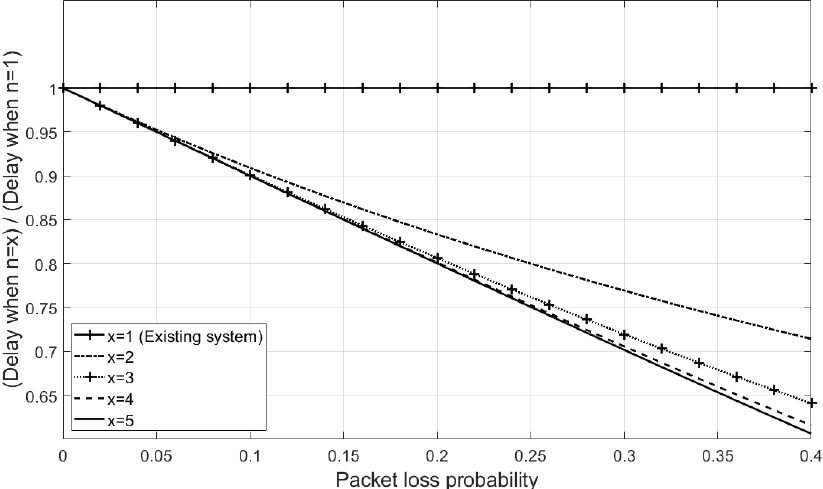
Figure 5. The ratio of delay when using MuTran in TCP-mode to that when using the existing